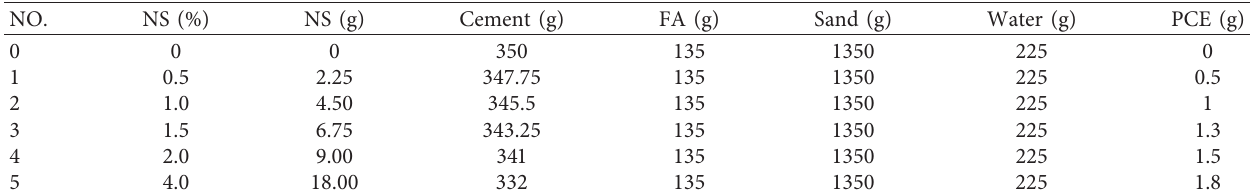
Table 2: Mix proportion of mortars and